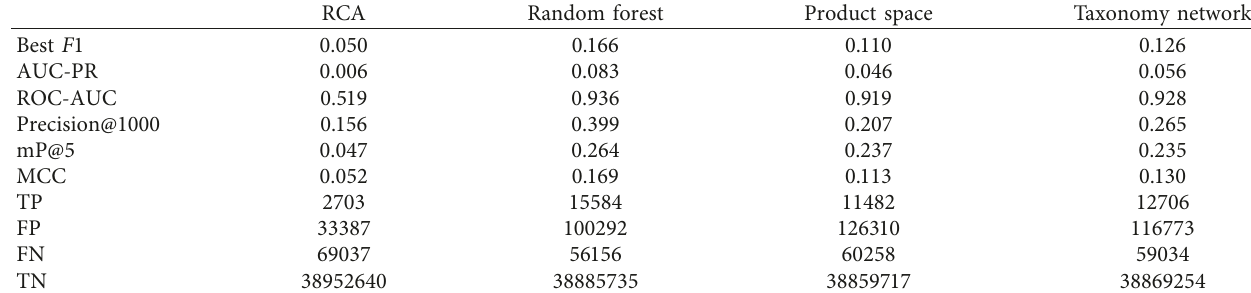
Table 2: Prediction performance of firm-based models. Our problem is characterized by a huge number of true negatives, and this precludes the use of metrics such as accuracy and ROC-AUC. In any case, the random forest outperforms all other